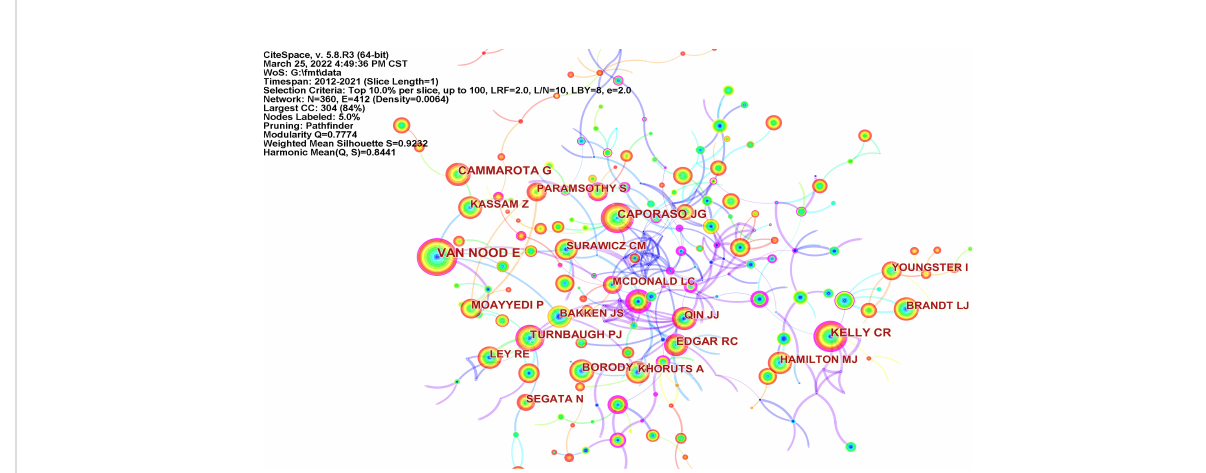
FIGURE 6 Map of cited authors performing FMT-related research (N=360, E=412).